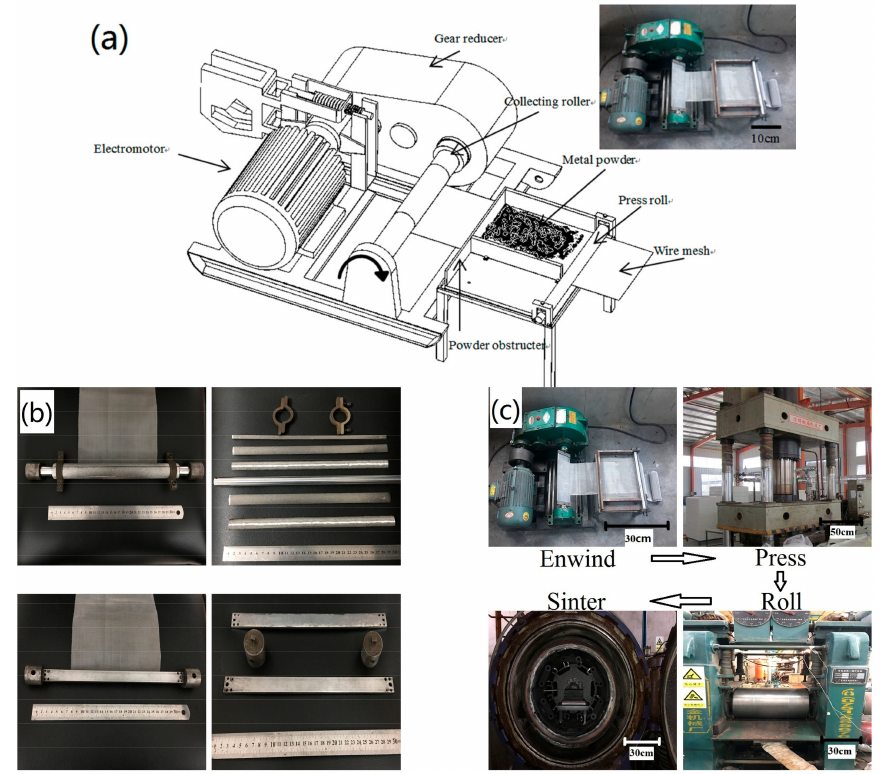
Figure 1. ( a ) The structure of the winding system; ( b ) the structure of the modularly designed core-plates; and ( c ) the fabrication process of the wire mesh porous plate